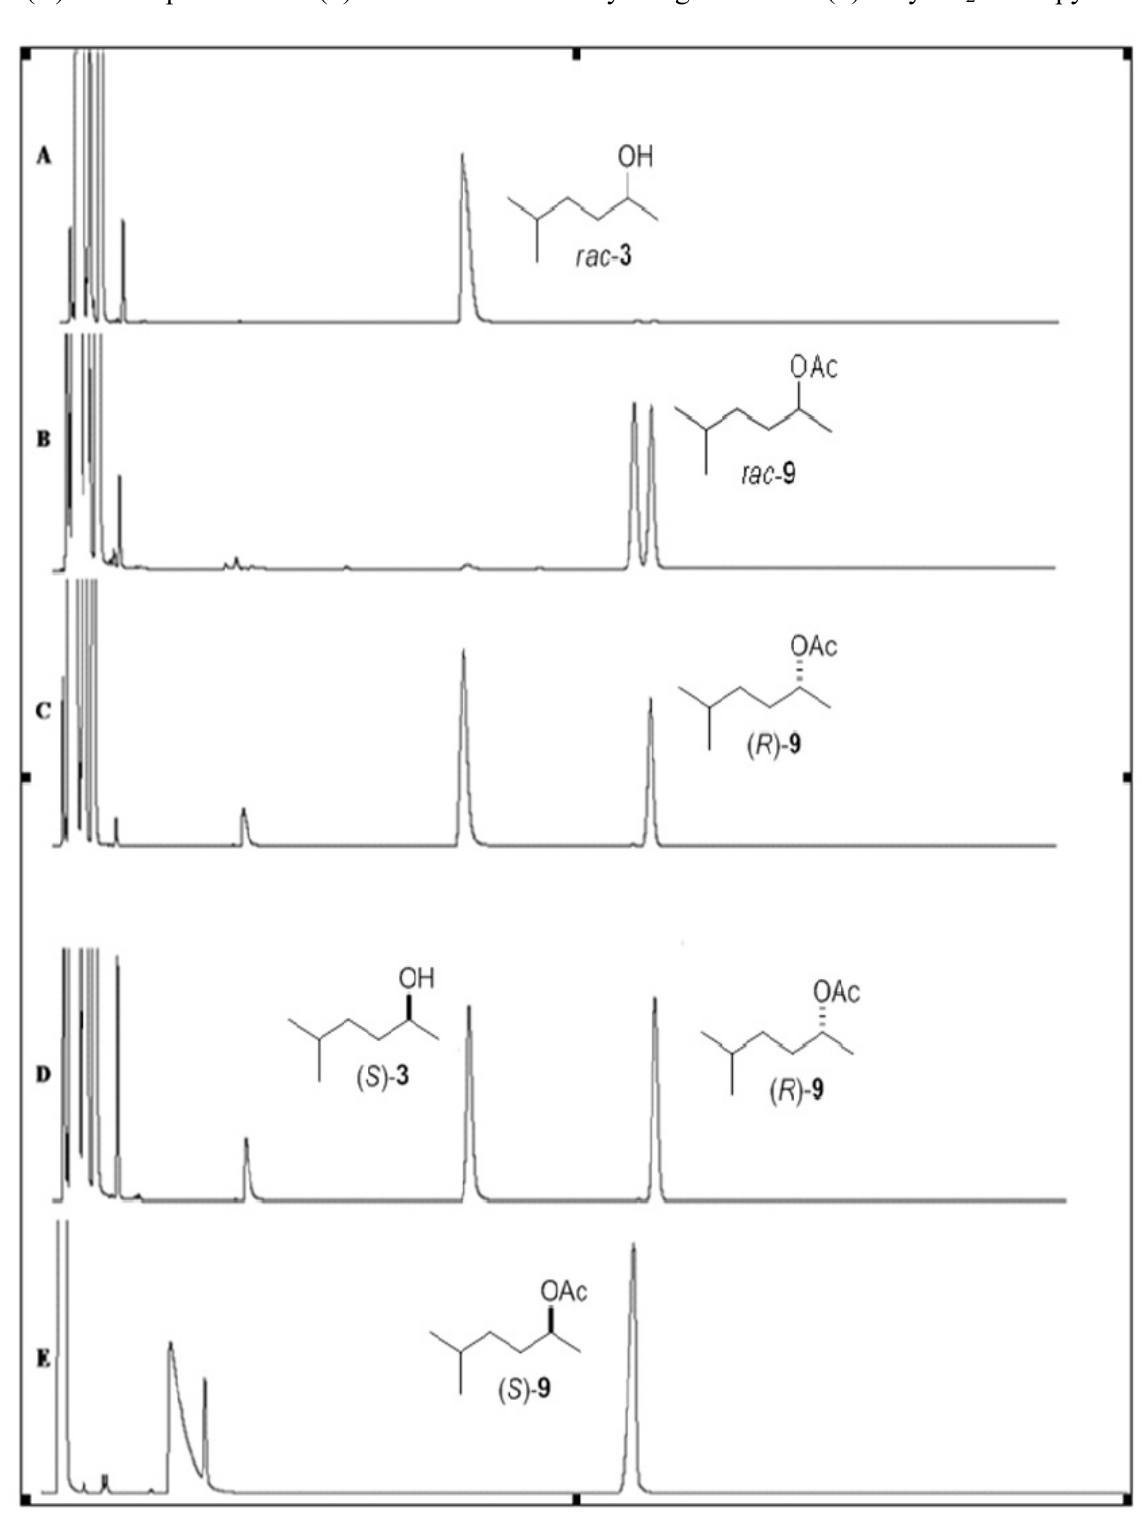
Figure 1. Chiral analyses obtained by GC-FID chromatograms. ( A ) Racemic alcohol (±)- 3 . ( B ) Racemic acetate (±)- 9 . ( C ) Chromatograms of the kinetic resolution of rac - 3 by lipase CALB (20 min). ( D ) Chromatograms of the kinetic resolution of rac - 3 by lipase CALB (40 min). ( E ) Enantiopure acetate ( S )- 9 obtained after acetylating of alcohol ( S )- 3 by Ac